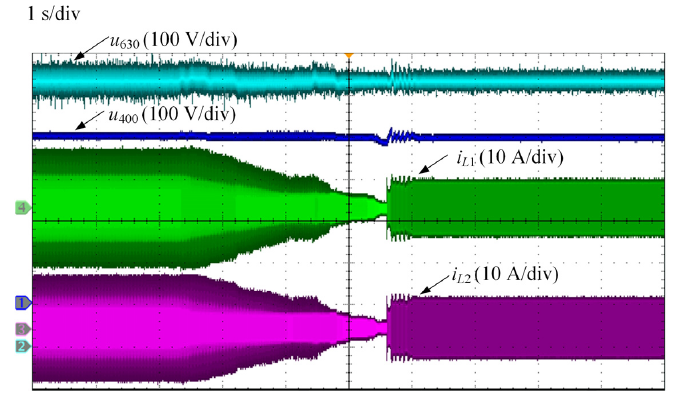
Figure 19. Waveforms of AC load transition from 7 kW to 0 in on-line mode with the new control scheme.